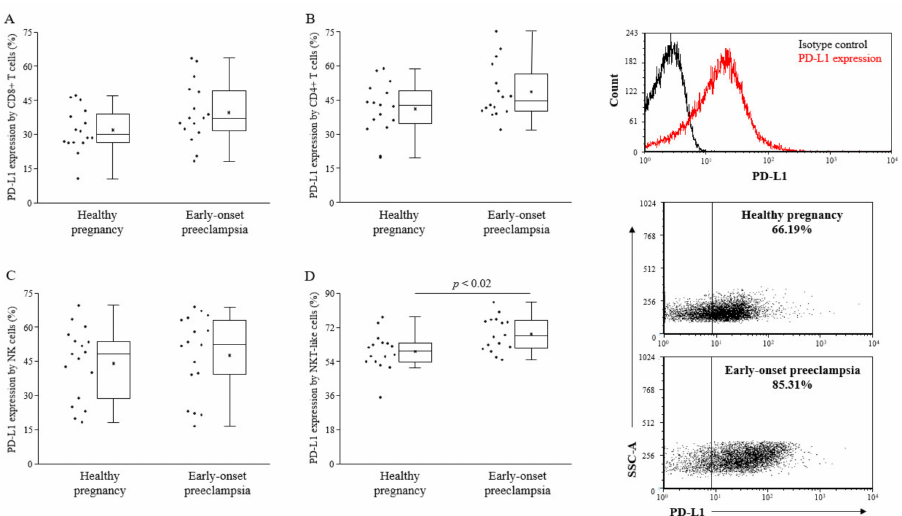
Figure 2. PD-L1 expression by peripheral lymphocyte populations in 3rd-trimester healthy pregnant women and in women with early-onset preeclampsia. The expression of PD-L1 CD8+ T cells ( A ), CD4+ T cells ( B ), NK cells ( C ), and NKT-like cells ( D ) in peripheral blood of women with early-onset preeclampsia and in healthy pregnant women. The solid bars represent medians of 17 and 17 determinations, respectively, the boxes indicate the interquartile ranges, and the lines show the most extreme observations. Differences were considered statistically significant for p -values ≤ 0.05.